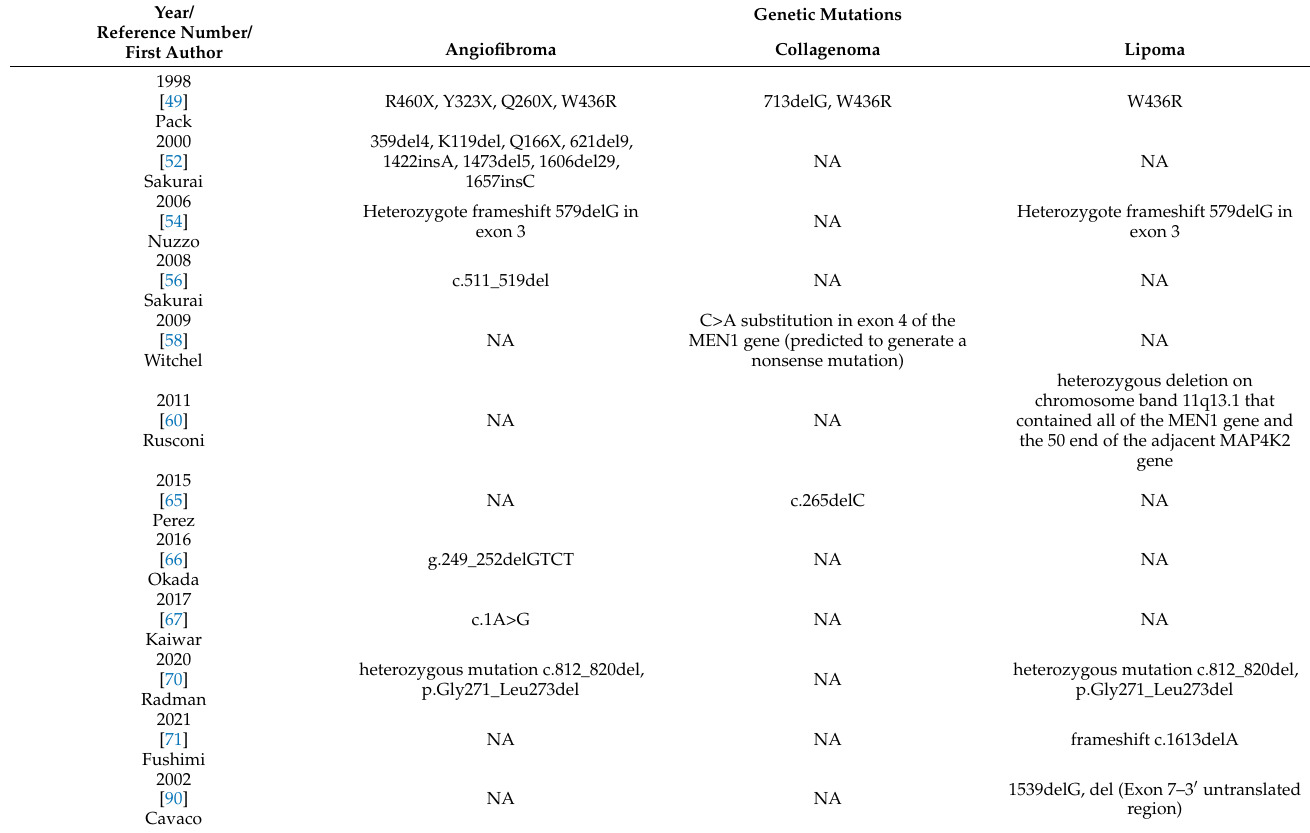
Abbreviations: MEN1 = multiple endocrine neoplasia; NA = not